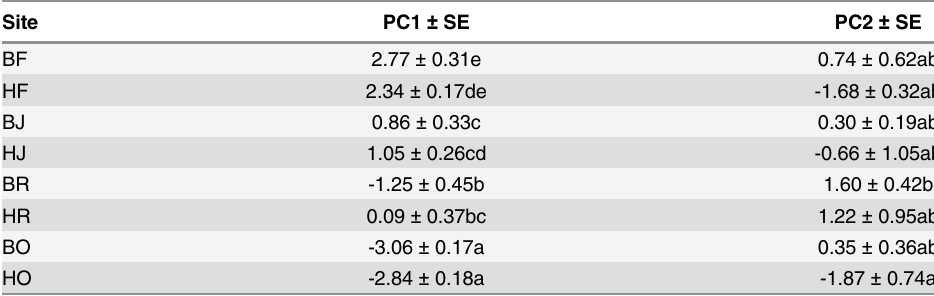
intensity also corresponded to loss of ecosystem functions indicated by soil properties. Soil (sum of base cations, available phosphorus, pH, water content, carbon, nitrogen) and litter properties (carbon, nitrogen), which we measured as proxies for ecosystem functions showed significant variations among different sites (Table 5). An NMDS conducted with the significant loadings of RCWTs for PC1 (Table 2) and the environmental variables (Table 5) as explanatory vectors indicated that soil pH and soil N were related to the negative scores of oil palm and rub- ber plantations, while soil C and litter N and C were related to the positive scores of rain forest and jungle rubber (Fig 5). However, it should be noted that the overall pH differences between the plots were small (Table 5, mean pH of rain forest plots: 4.25 ± 0.03 and mean pH of the other land use systems: 4.46 ± 0.13, P = 0.002). To find out whether the PC1 scores which distinguish the land use systems independently from landscape can be quantitatively related to ecosystem functions, we tested general linear models. The PC1 scores were used as dependent and the environmental properties as indepen- dent variables. The categorical factors land use system and landscape were not included in the model, because they had been used to determine the PC1 components. The model with the lowest AIC contained three significant components: soil nitrogen concentration, soil pH and Table 4. Mean PC scores of the land use systems.